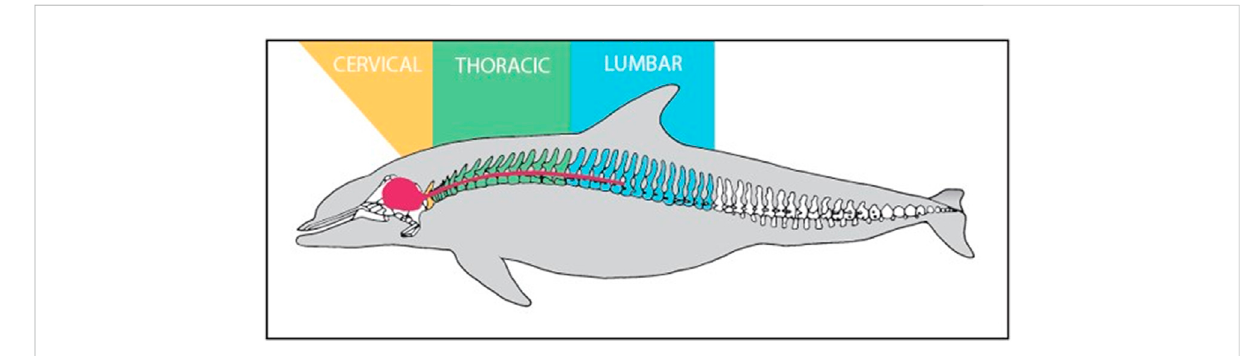
FIGURE 2 Labeled vertebral column and CNS (Red) of Tursipous truncatus (Rommel, 1990).